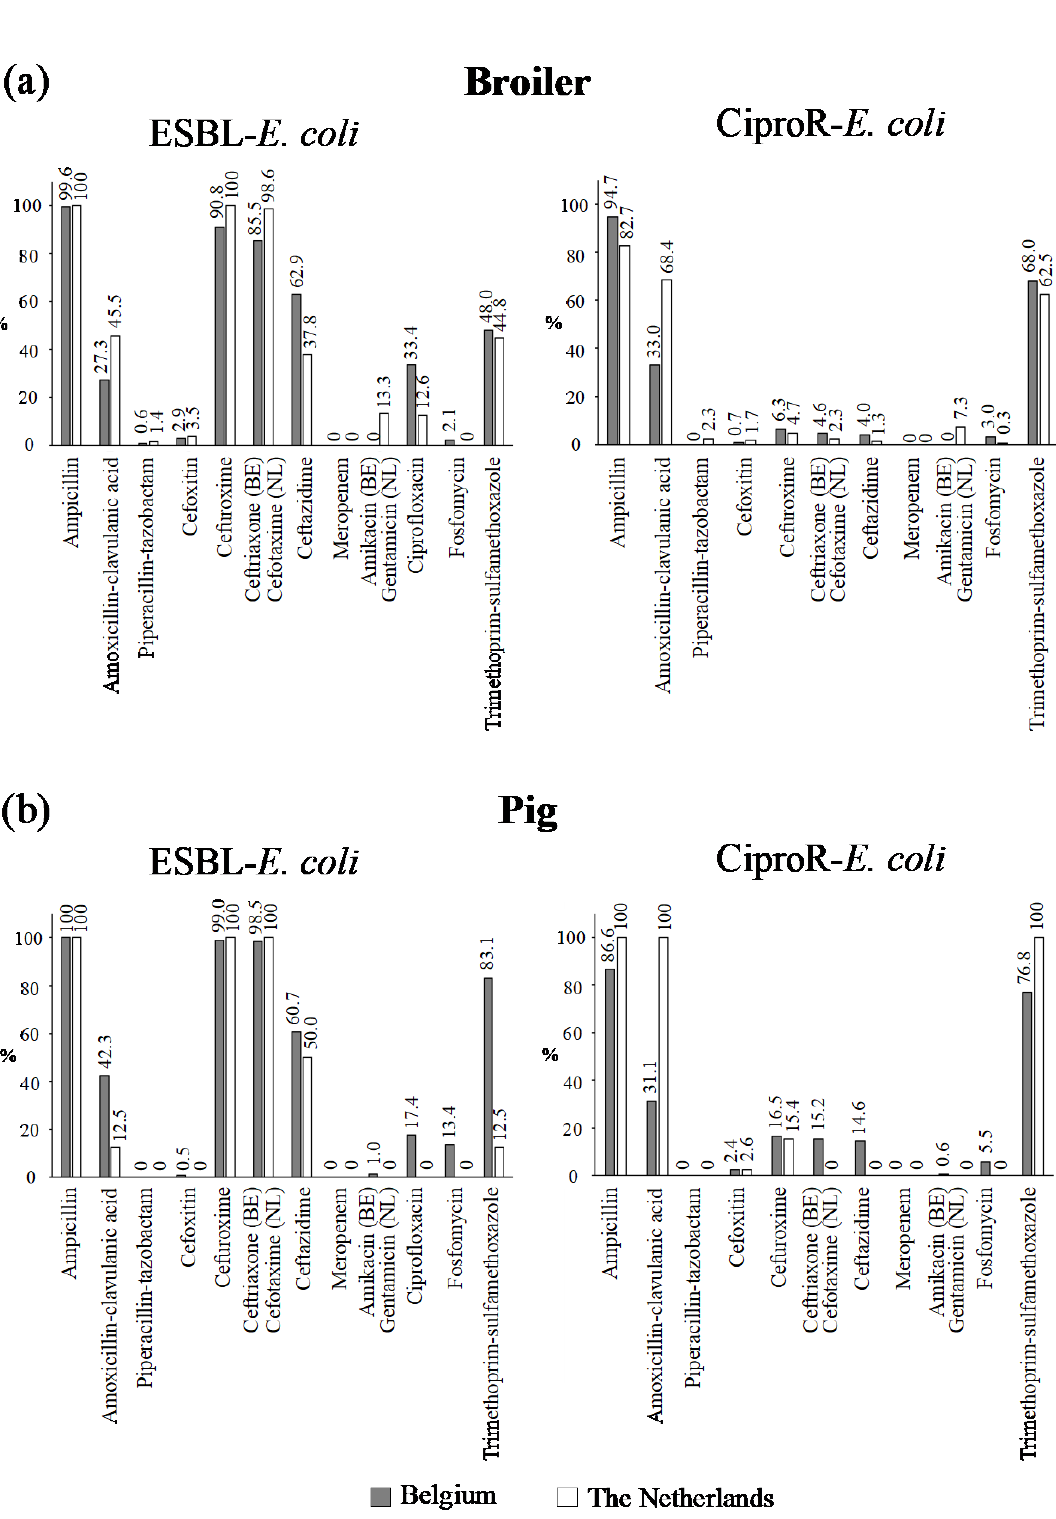
Figure 2. Percentage of antibiotic resistance per type of antibiotic in all ESBL- E. coli and CiproR- E. coli isolates from broiler chickens ( a ) and weaned pigs ( b ) in Belgium and the Netherlands. Number of ESBL- E. coli from broilers: N BE = 523, N NL = 143, number of CiproR- E. coli from broilers: N BE = 303, N NL = 301. Number of ESBL- E. coli from pigs: N BE = 201, N NL = 16, number of CiproR- E. coli from pigs: N BE = 164, N NL = 39.